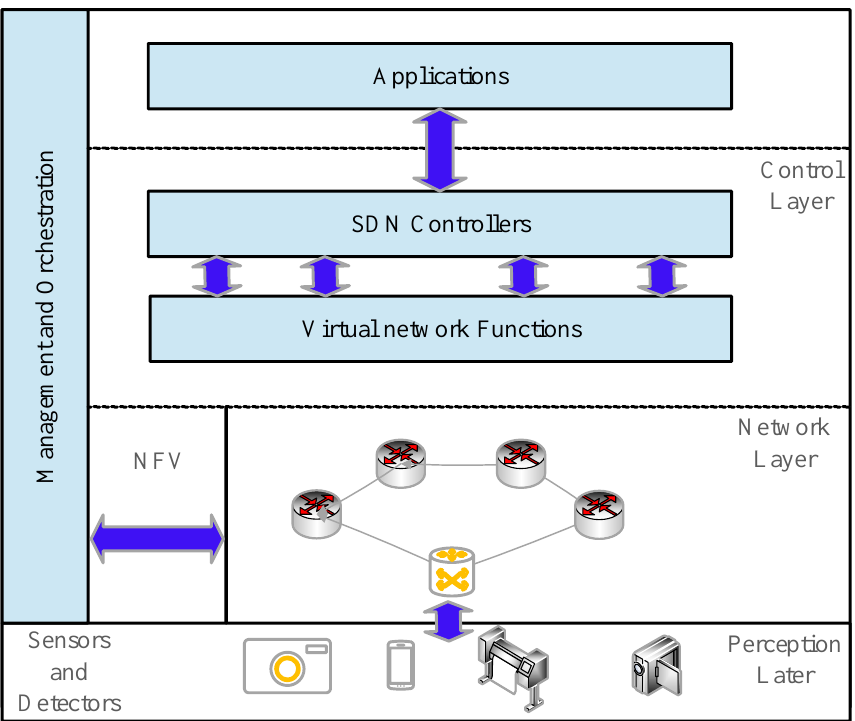
Figure 3. AIoT Architecture with SDN and